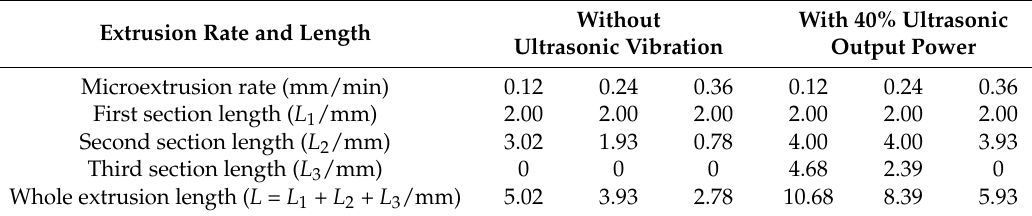
Figure 8. XRD results of ultrasonic uniaxial compressed Zr35 sample.